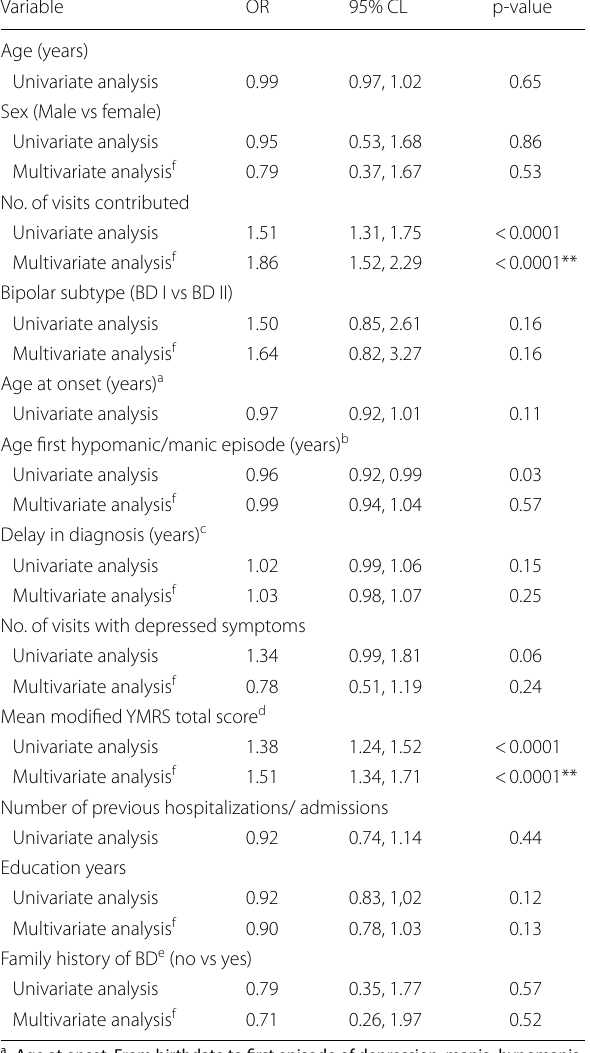
Table 3 Logistic regression—prediction of DSM-5 criterion A fulfillment in 373